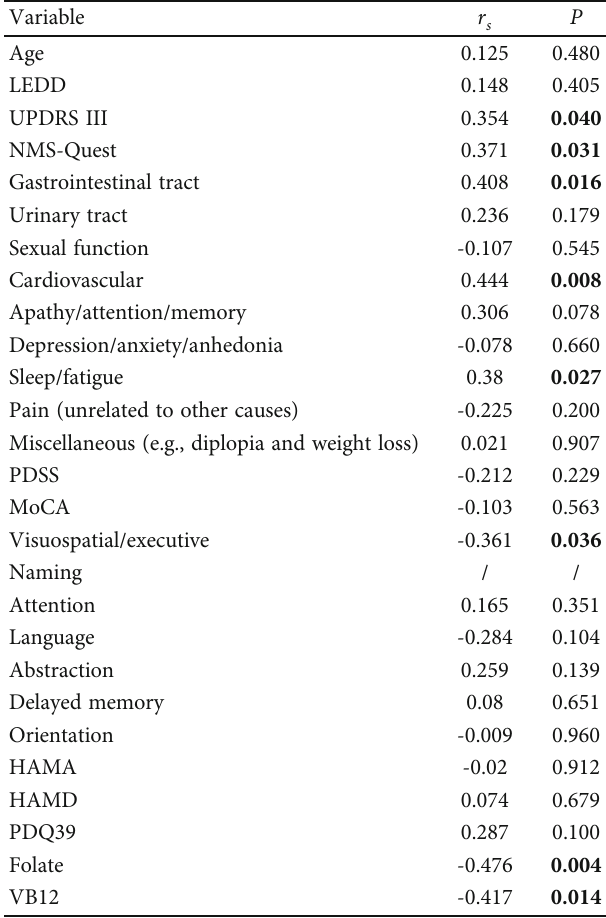
Table 5: Correlations between Hcy and clinical